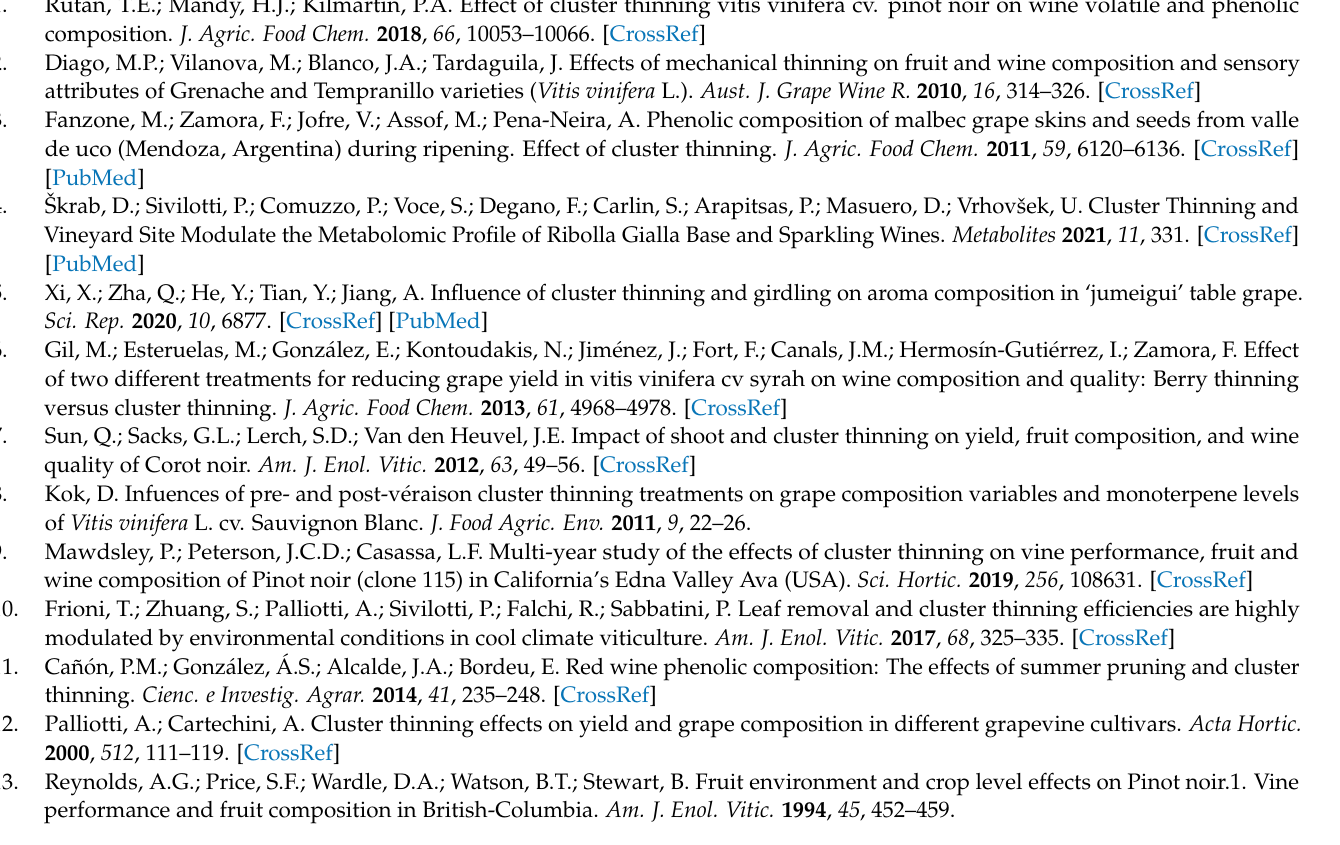
classification on brown module genes, Figure S4: KEGG analysis on brown module genes. Table S1: Changes of free monoterpenes profiles in Muscat Hamburg grape at six developmental stages, Table S2: Changes of bound monoterpenes profiles in Muscat Hamburg grape at six developmental stages. Table S3: Sequencing Data Statistics, Table S4: KEGG enrichment analyses of DEGs, Table S5: Number of genes in each WGCNA